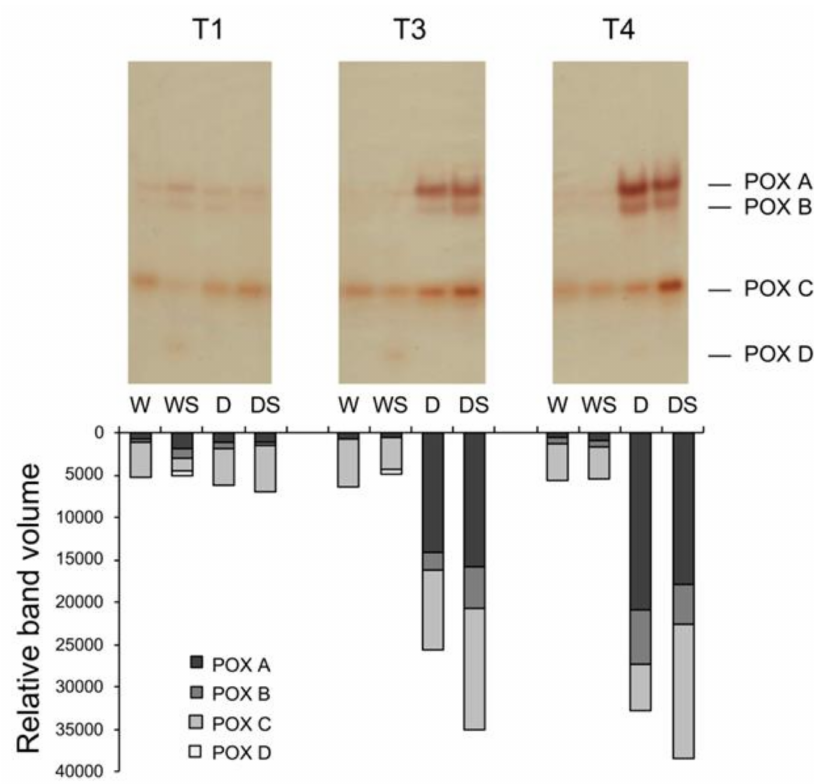
Figure 7. Zymograms of peroxidase (POX) isoforms. Total soluble proteins isolated from leaves (100 µ g protein / lane) of watered plants (W), drought-stressed plants (D), watered plants treated with SA (WS) or drought-stressed plants treated with SA (DS) were separated by native PAGE and assayed for POX activity using guaiacol as a substrate. T0–T4 are di ff erent sampling points (see Figure 1). Densitometrically determined individual POX activities are represented by